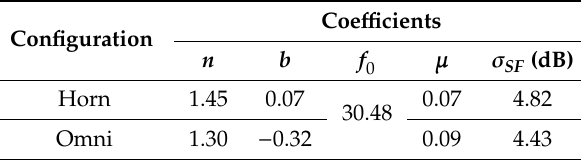
Figure 6. Close-in with frequency dependency (CIF) fitting for ( a ) Horn (asterisk) and ( b ) Omni (circle) configurations at 26 (red), 32 (blue) and 39 GHz (green). Table 4. LOS CIF fitting coe ffi